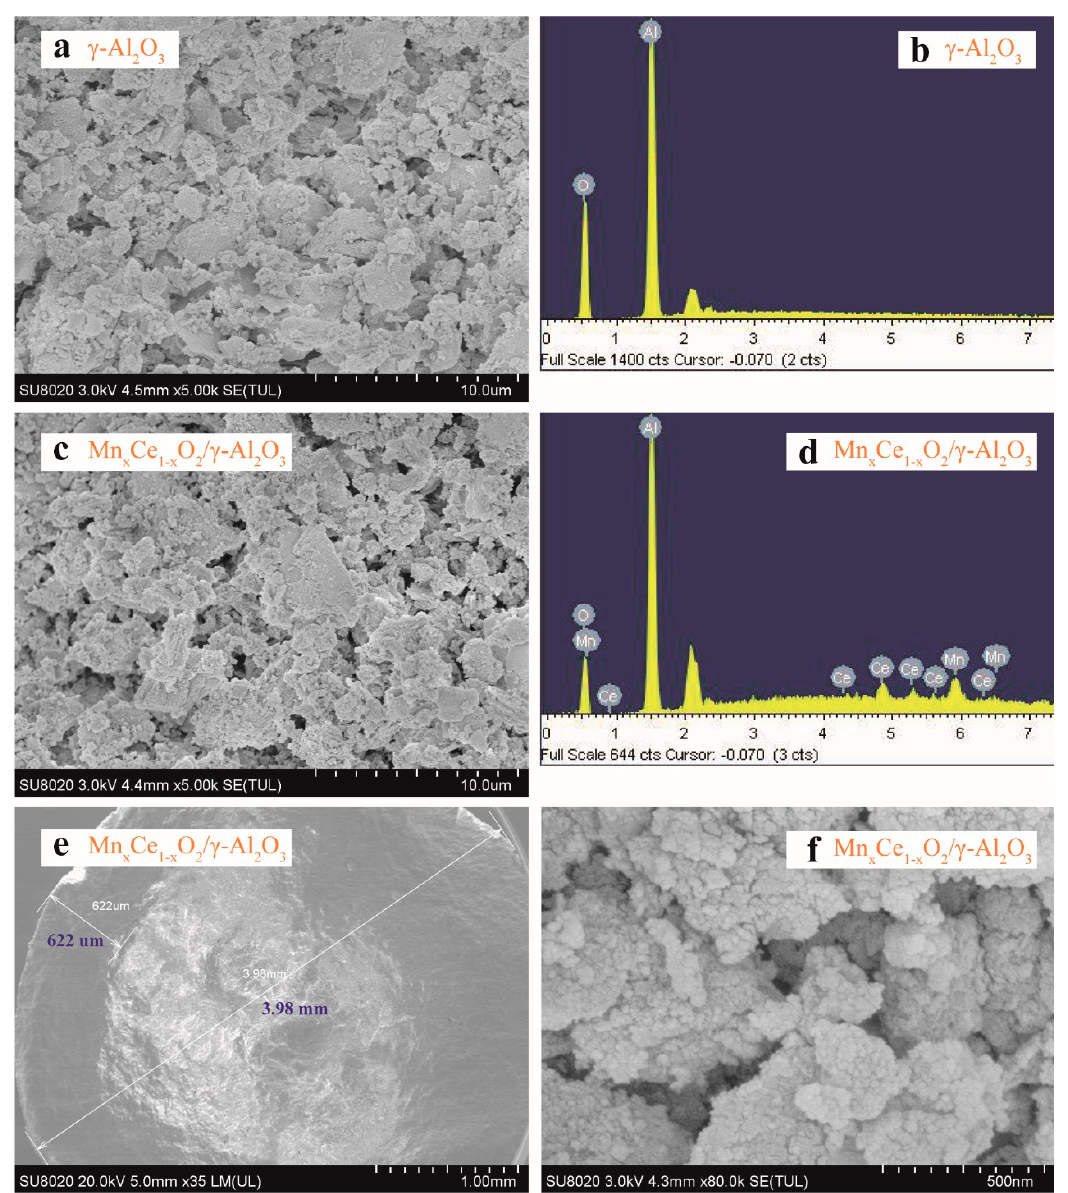
Figure 4. SEM and EDS analysis results: ( a ) SEM of γ -Al 2 O 3 support, ( c , e , f ) SEM of Mn x Ce 1-x O 2 / γ -Al 2 O 3 catalyst, ( b ) EDS of γ -Al 2 O 3 support, ( d ) EDS of Mn x Ce 1-x O 2 / γ -Al 2 O 3 catalyst.